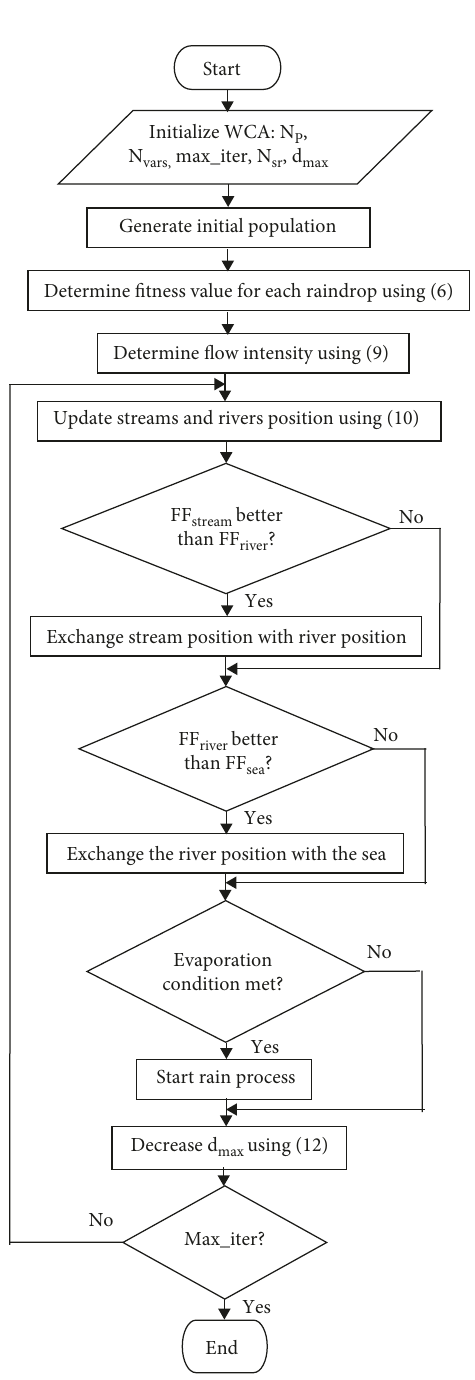
Figure 6: Water Cycle Algorithm flowchart Table 3: WCA parameters [43].